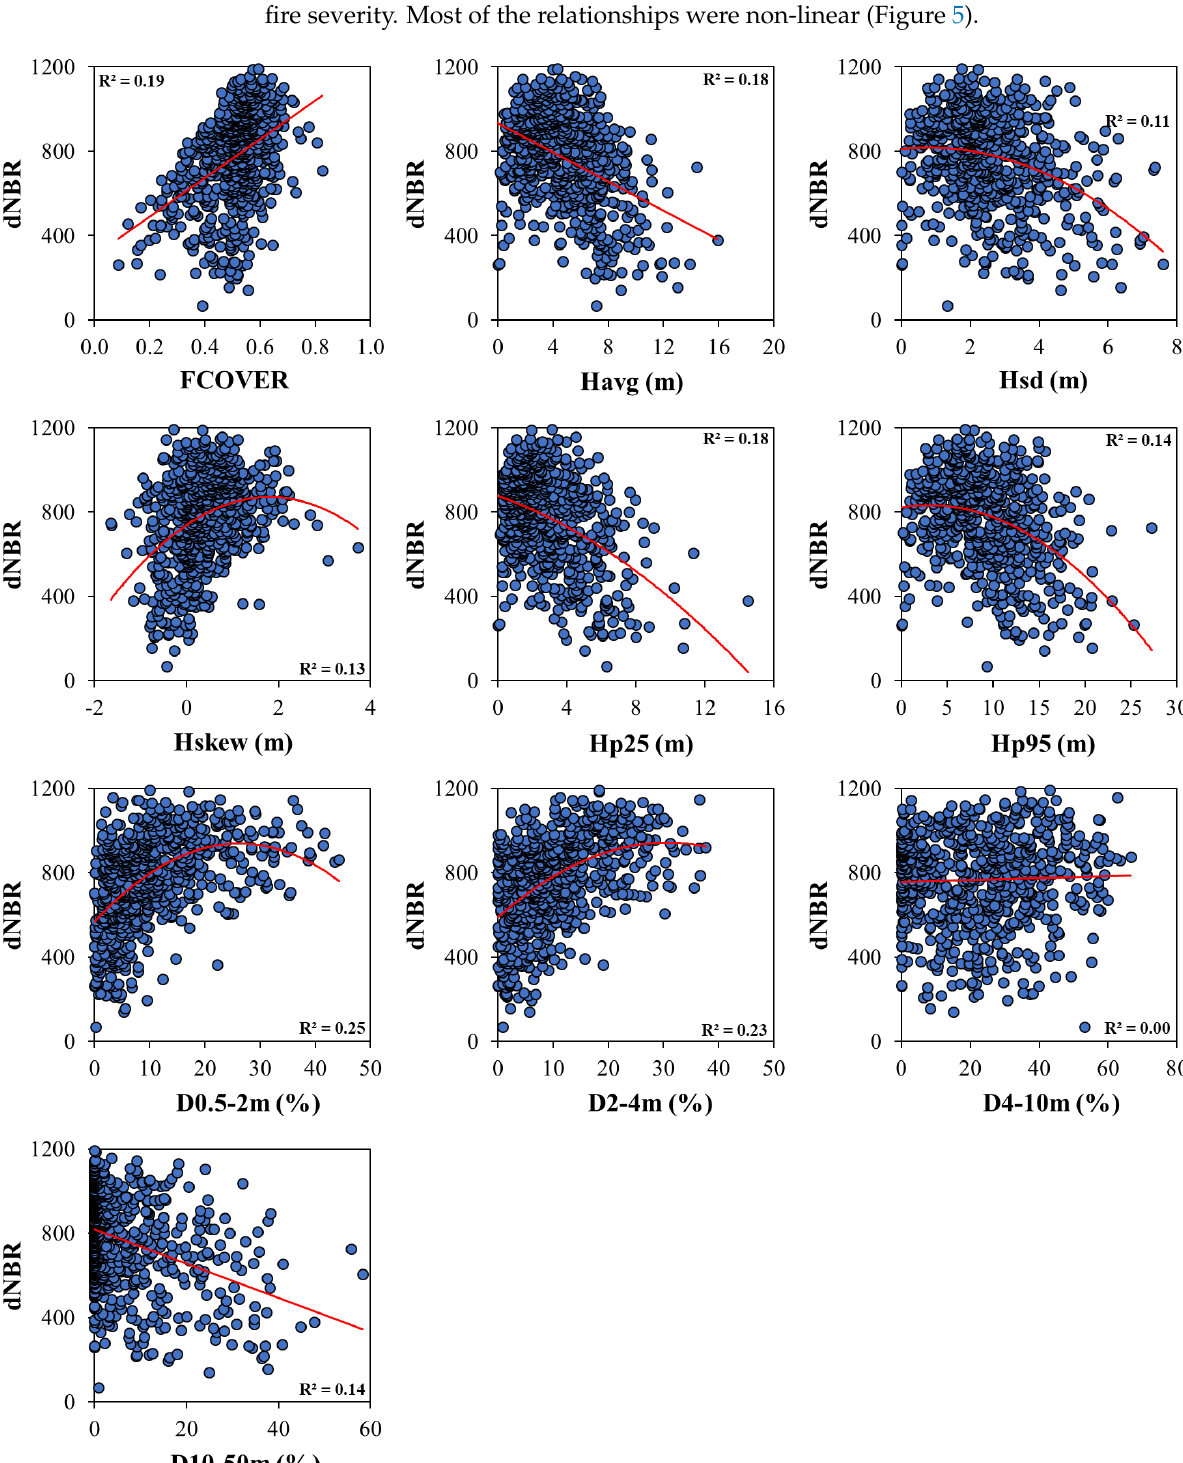
Figure 5. Relationships between fire severity (dNBR) and pre-fire LiDAR metrics. The solid line represents the fit of the linear model.